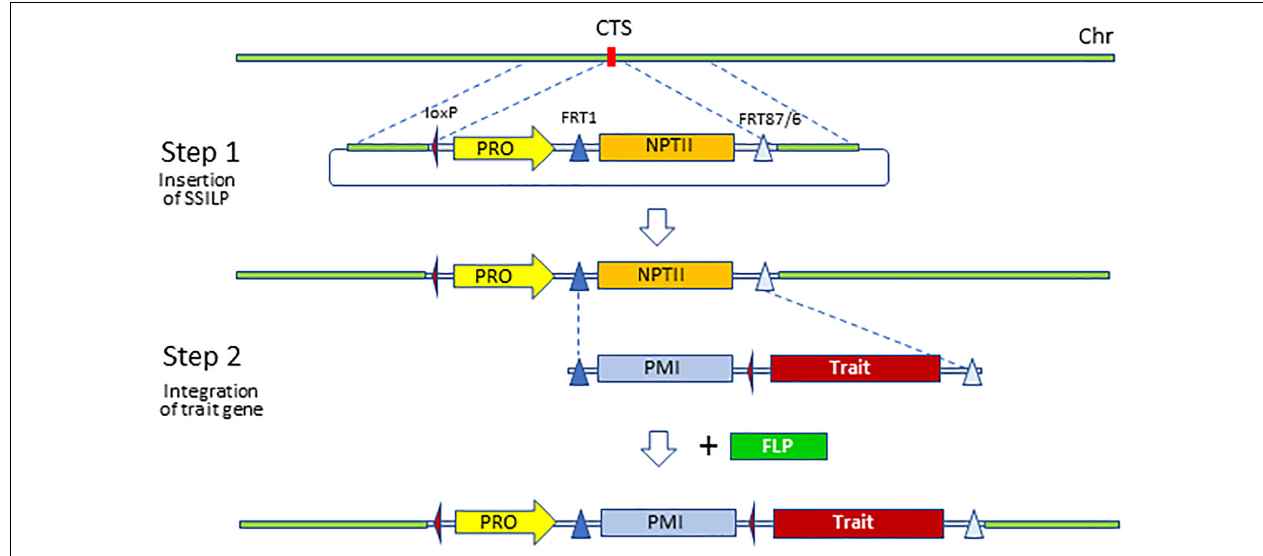
FIGURE 2 | Two-step strategy to integrate trait gene to preselected sites. Site-specific insertion landing pad (SSILP) was inserted to a CRISPR-Cas9 target site (CTS) via homology-directed repair. Lines containing the SSILP can be retransformed with a trait gene which is integrated to the SSILP via RMCE. The PRO in SSILP serves as promoter trap for the selection marker in the trait gene vector. The selectable marker phosphomannose isomerase (PMI) can be removed via CRE-mediated recombination if desired. FLP, flippase recombinase; FRT, flippase recognition target; loxP, side triangle, locus of X-over P1 site; PRO, promoter; NTPII, neomycin phosphotransferase II; Chr,